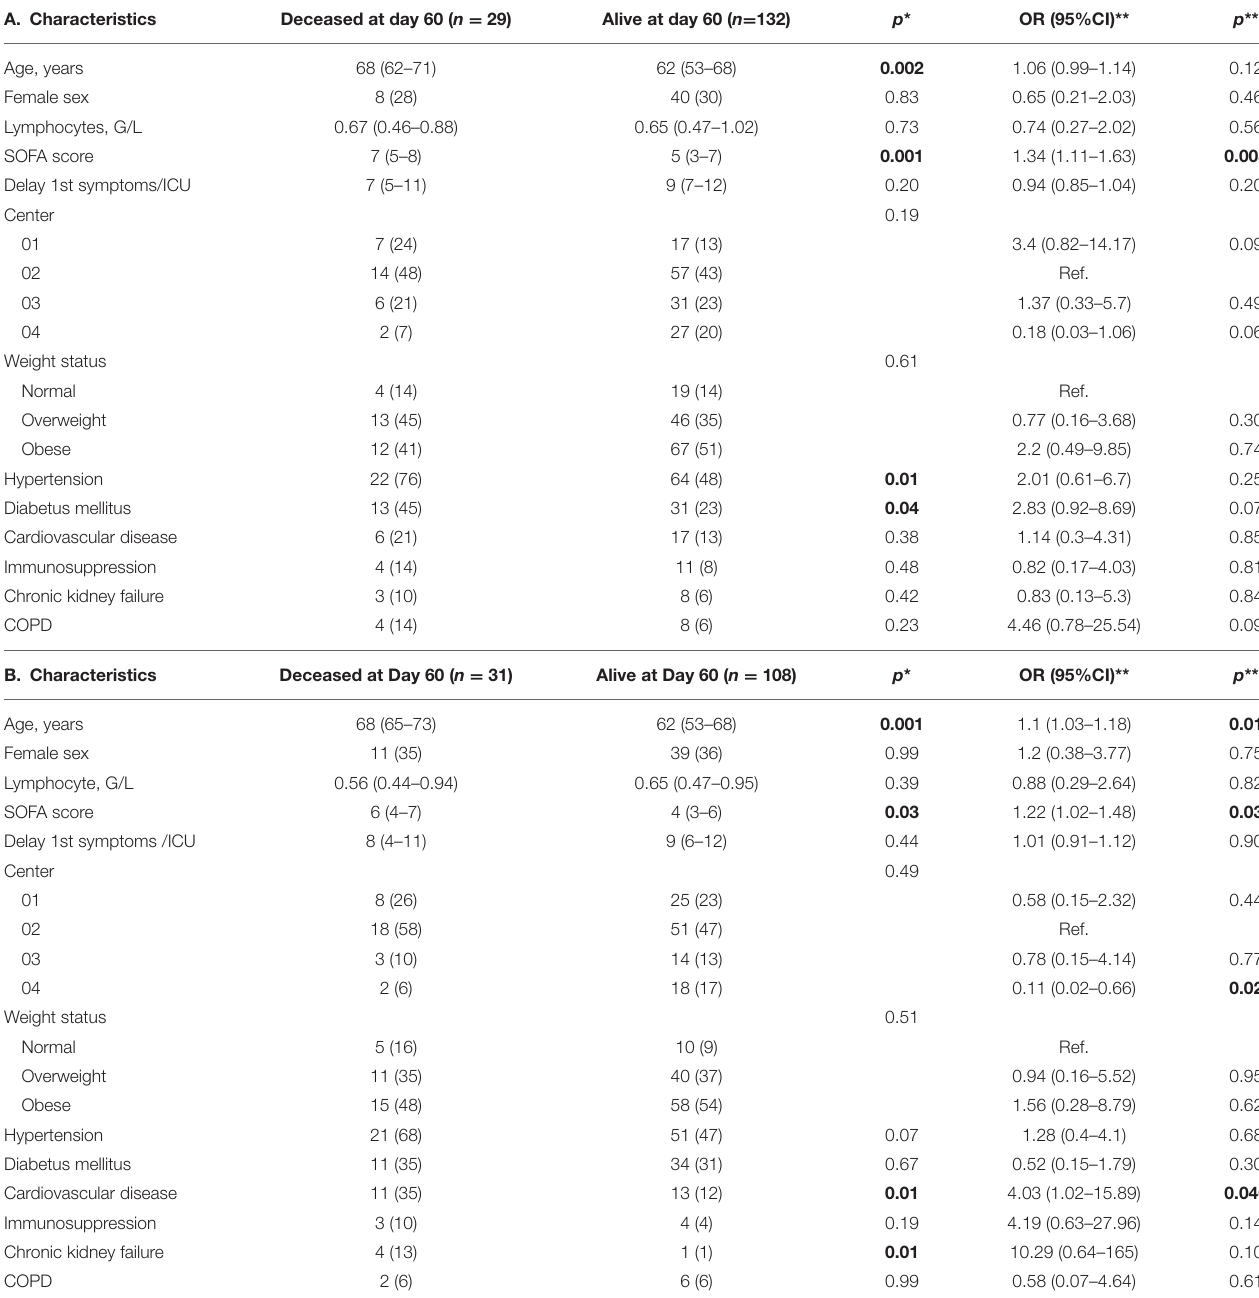
TABLE 3 | Logistic regression analysis to determine the factors that associated with mortality 60 days after admission in ICU for an infection with (A) Alpha ( n = 161 a ) or (B) Beta ( n = 139 b